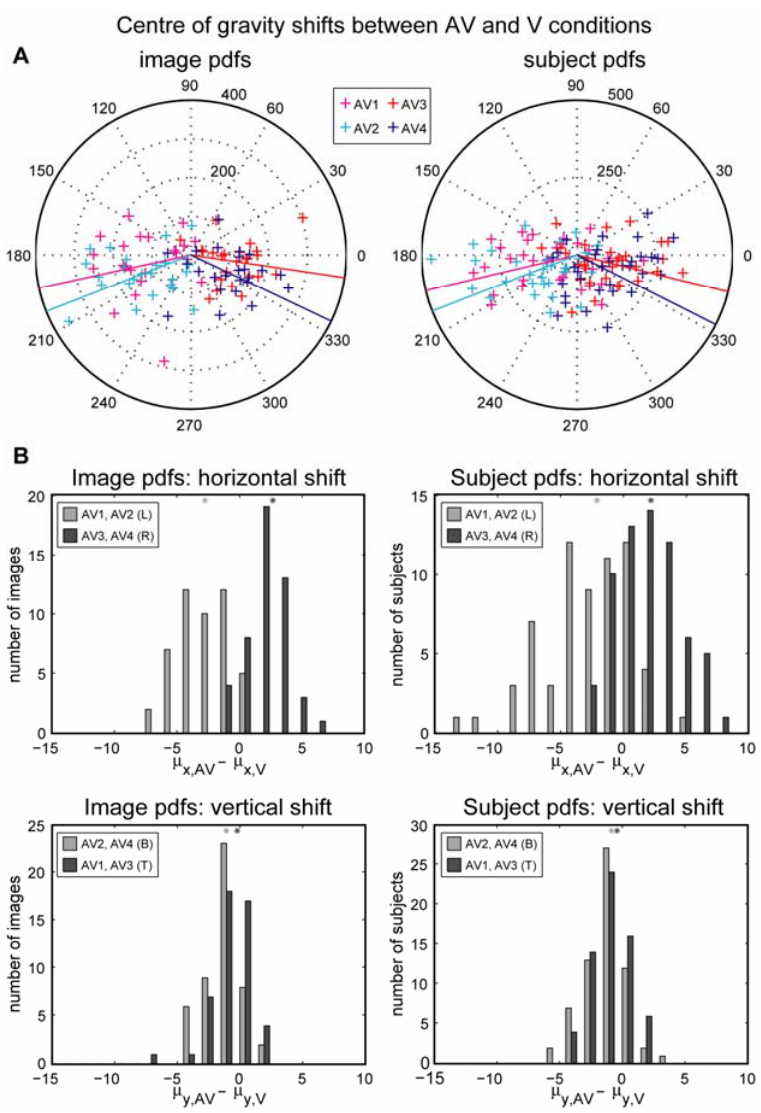
Figure 6. Shift in fixation towards sound location. The shifts in fixation density between visual (V) and each audiovisual condition (AV1-4) are calculated by a simple subtraction of the centres of gravity of image- or subject-matched visual and audiovisual pdfs. A: The distribution of fixation shifts are shown here in polar co-ordinates, for all image pdfs (left plot, N=24) and subject pdfs (right plot, N=32). Each point depicts the shift between a V and AV pdf for a single subject or image, with audiovisual condition coded by colour (see legend). The (vector) mean over all subjects or images for a single condition is drawn as a single line – the magnitude of these lines is purely for visualisation purposes and does not represent any variance within conditions. B: Histograms of horizontal (upper plots) and vertical (lower plots) shifts in fixation density for all image pdfs (left plots, N=24) and subject pdfs (right plots, N=32), calculated separately from Cartesian coordinates of centres of gravity. For horizontal shifts, the data are grouped by common azimuth of sound source (top-left and bottom-left sound sources in light grey vs. top-right and bottom-right in dark grey), with positive values describing shifts to the right. In the case of vertical shifts, data are grouped by common elevation (bottom/top sources in light/dark grey), and positive values indicate an upward shift. Values are given in visual degrees, and the median value of each distribution is indicated by an